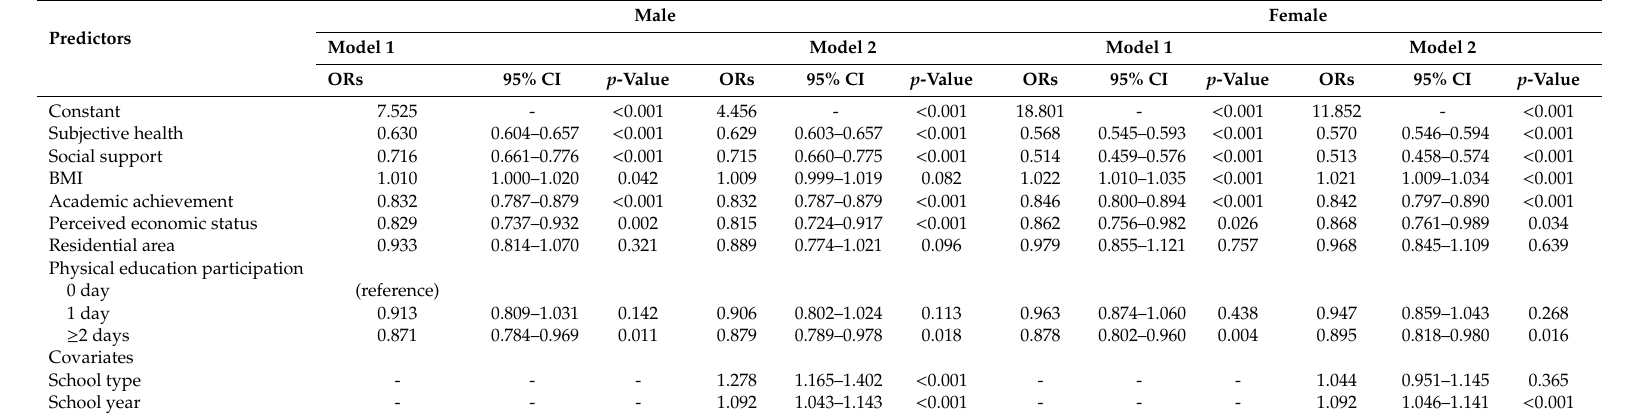
BMI = body mass index, ORs = odds ratio, CI = confidence